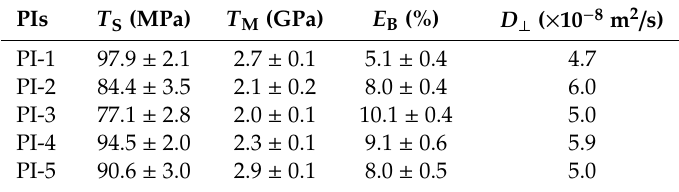
Table 2. Mechanical properties and thermal di ff usivities of semi-alicyclic polyimide films a . PIs T S